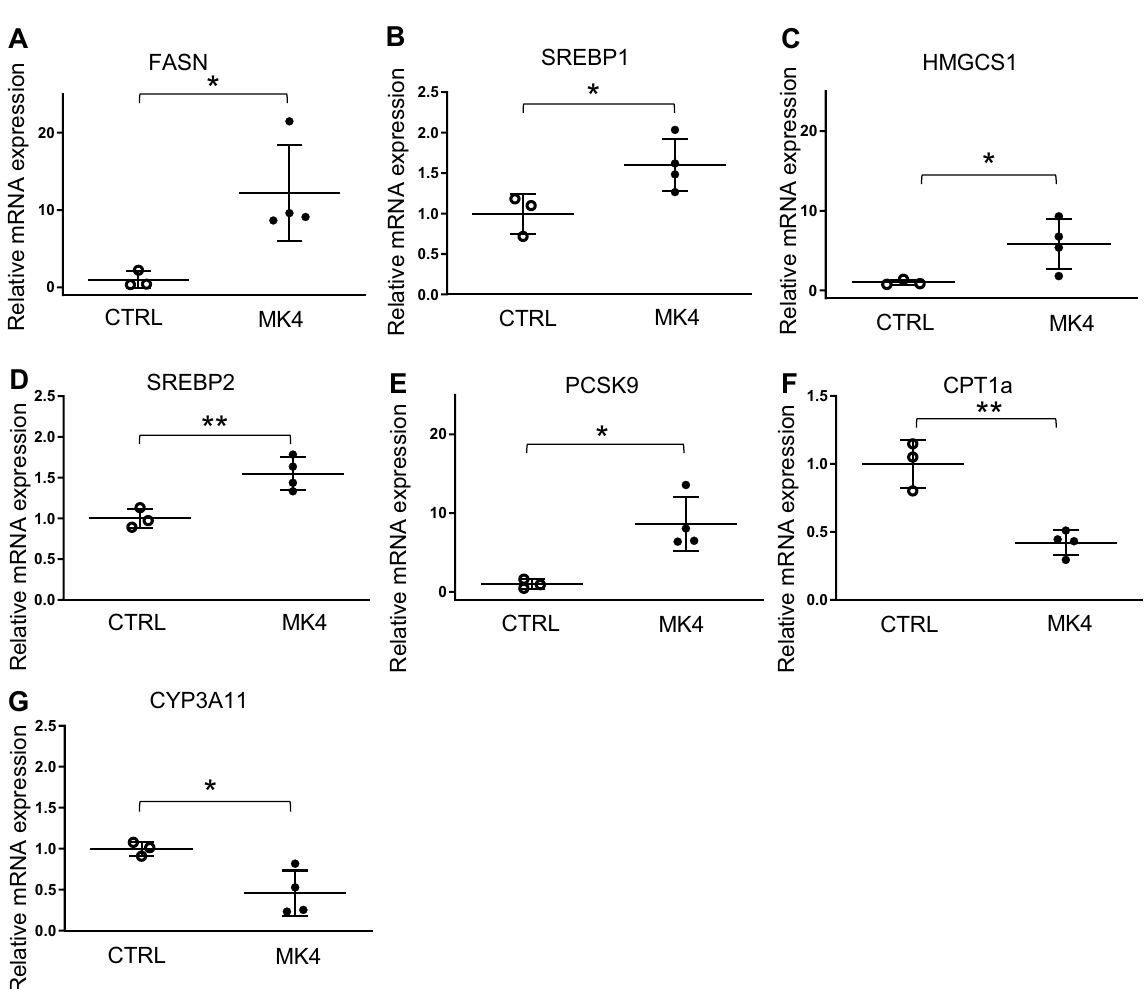
Figure 3. Effect of menaquinone 4 on hepatic gene expression in LDLr −/− ApoB 100/100 mice. ( A ) Fatty acid synthase ( Fasn ), ( B ) sterol regulatory element binding transcription factor ( Srebp1 ), ( C ) 3-hydroxy-3- methylglutaryl-Coenzyme A synthase 1 ( Hmgcs1 ), ( D ) Srebp22 , ( E ) proprotein convertase subtilisin/kexin type 9 ( Pcsk9 ), carnitine palmitoyltransferase 1a ( Cpt1a ) and cytochrome P450 family 3 subfamily A polypeptide 11 ( Cyp3a11 ). CTRL (n = 3), LDLr −/− ApoB 100/100 mice on Western diet (WD); MK4 (n = 4), LDLr −/− ApoB 100/100 mice on WD with menaquinone 4. Student´s t-test was used for statistical analysis. * p < 0.05, ** p <